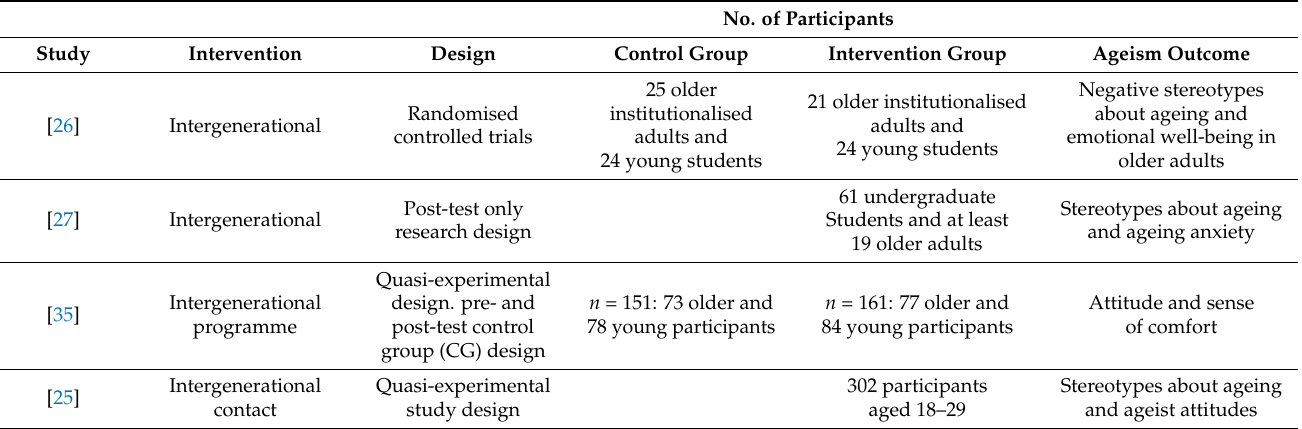
Table 1. Studies